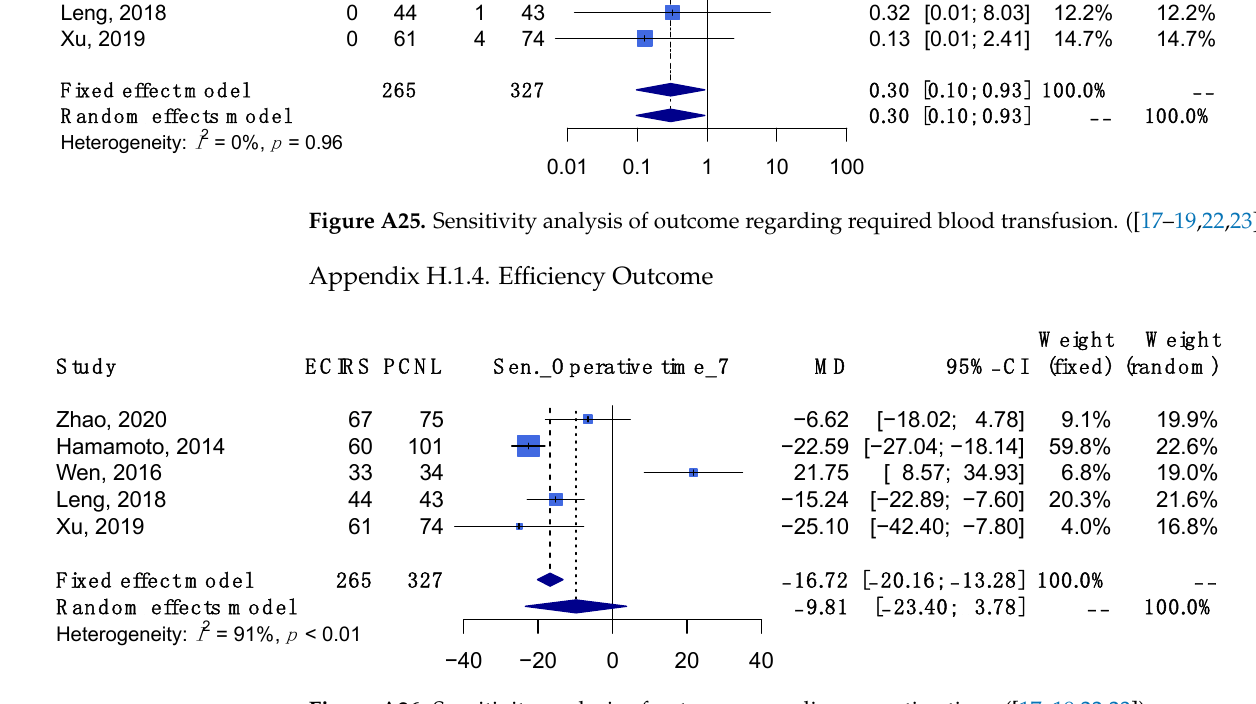
Figure A26. Sensitivity analysis of outcome regarding operative time. ([17–19,22,23])